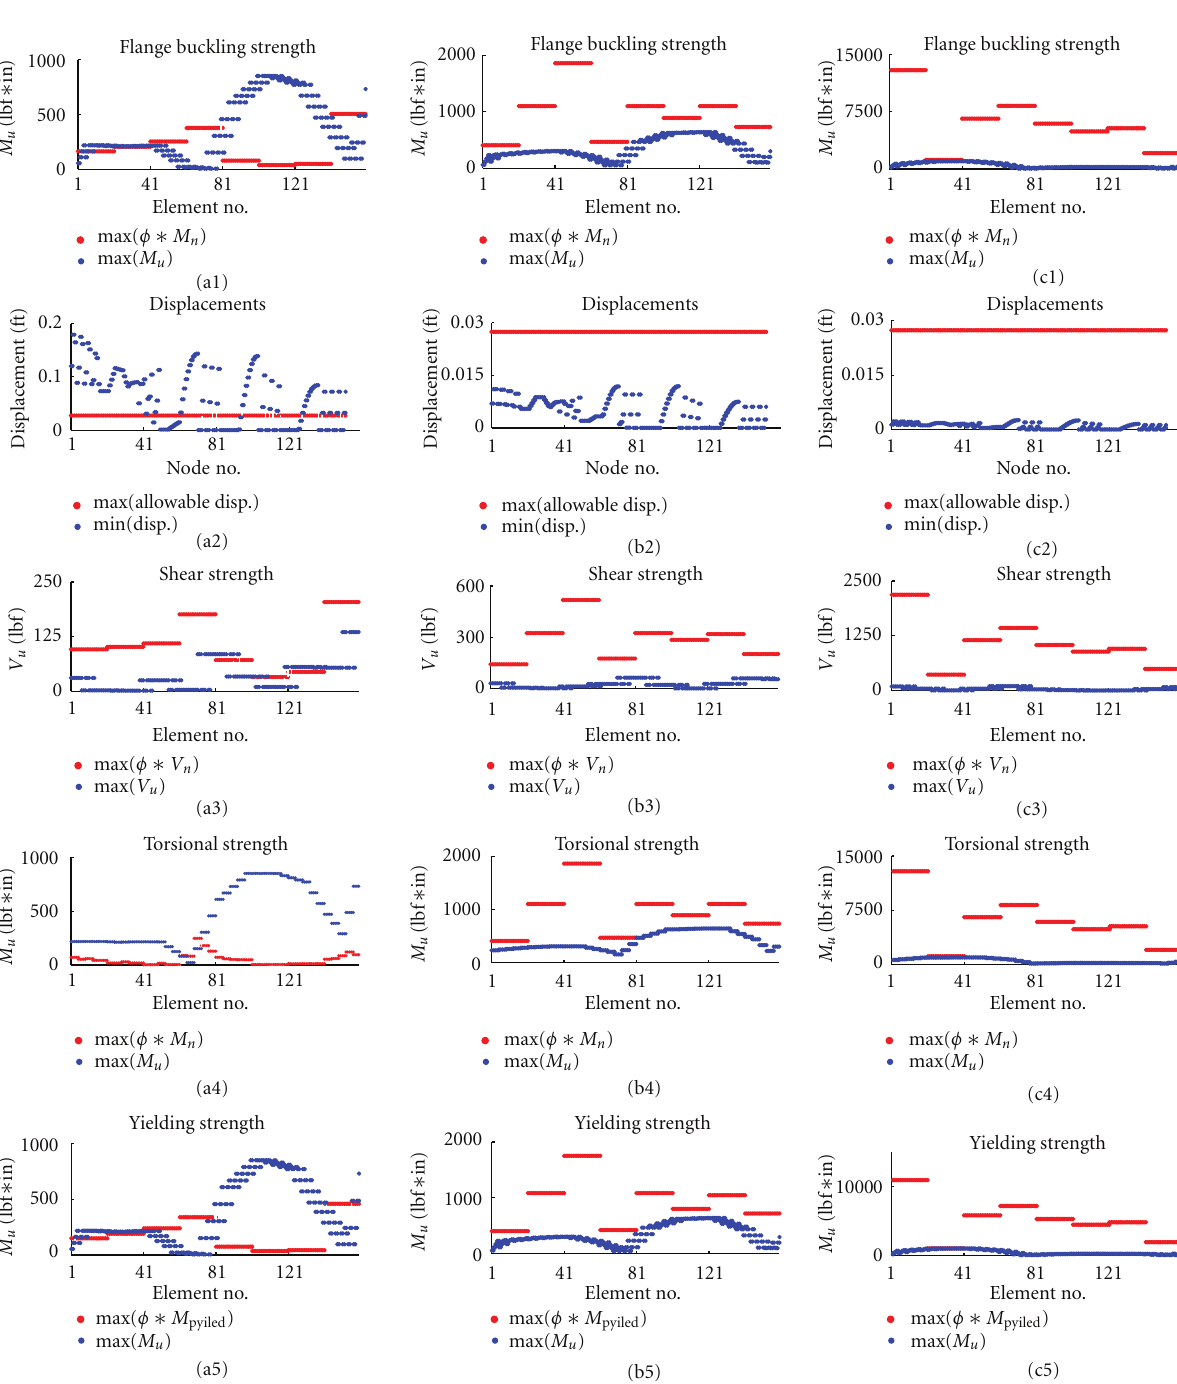
of the bigger cross-sectional properties for design